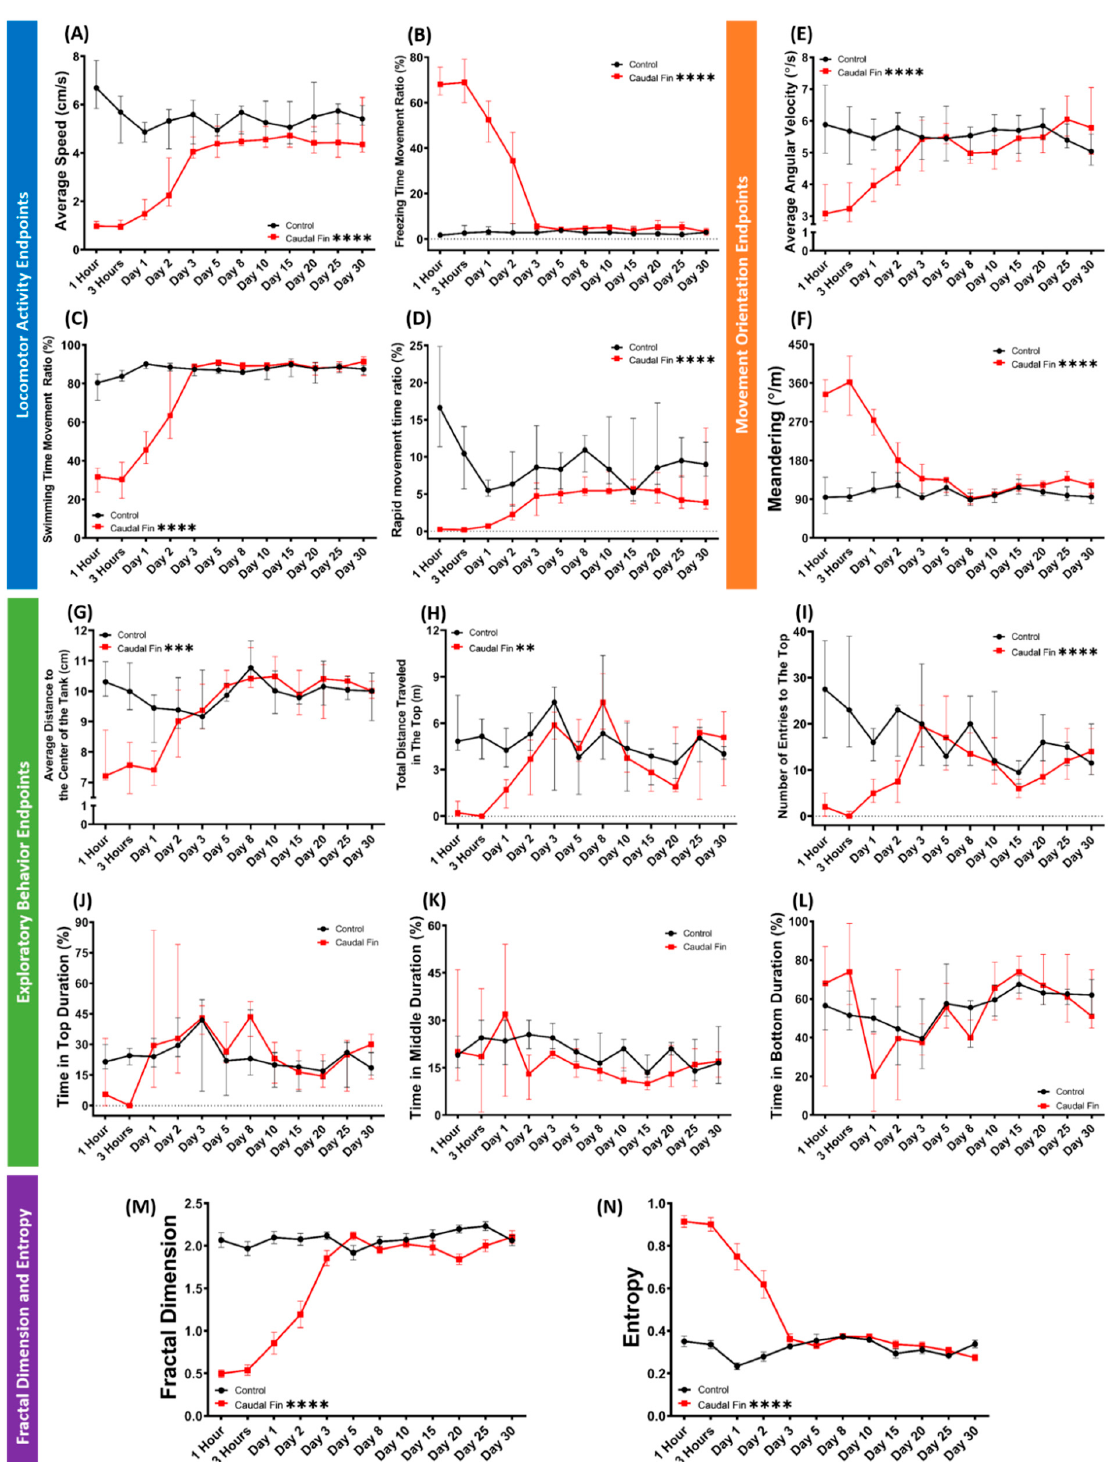
Figure 4. Comparison of grouped zebrafish behaviors in 3D locomotion test between caudal fin- amputated (red) and untreated (black) groups (shoal size = six fishes) during 30 days of observation. Twelve endpoints were measured and categorized into three groups. ( A ) Average speed, ( B ) freezing time movement ratio, ( C ) swimming time movement ratio, and ( D ) rapid movement time ratio belong to the locomotor activity endpoints group, while the movement orientation endpoints group consists of ( E ) average angular velocity and ( F ) meandering. Finally, the exploratory behavior endpoints